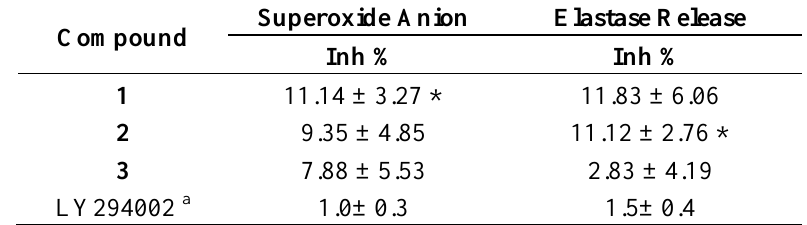
Table 3. Effects of pure compounds on superoxide anion generation and elastase release in FMLP/CB-induced human